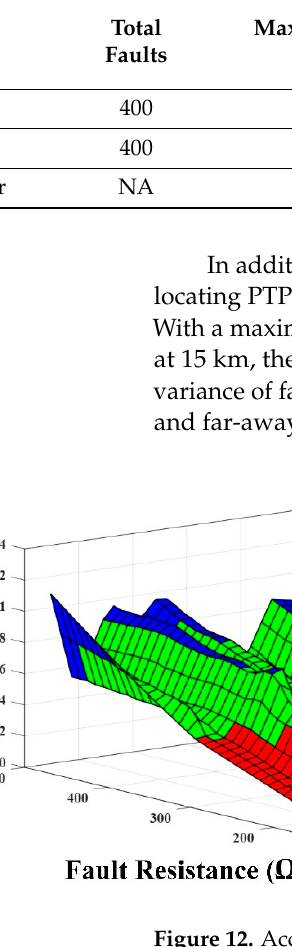
Figure 12. Accuracy of the proposed technique .